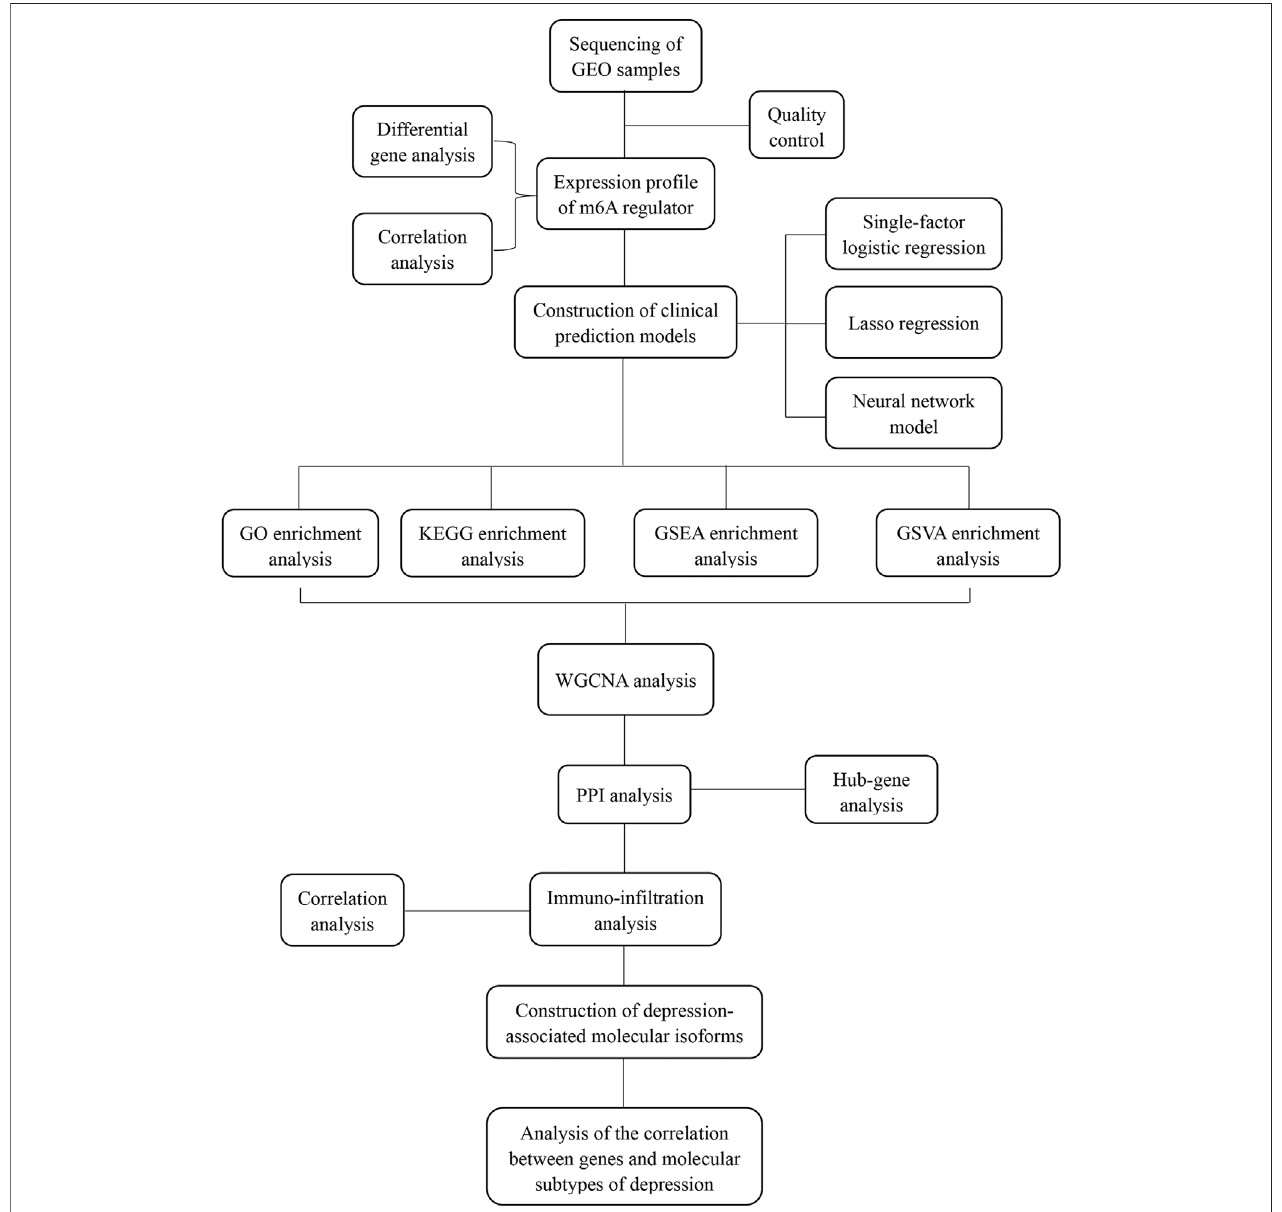
FIGURE 1 | Analysis fl ow